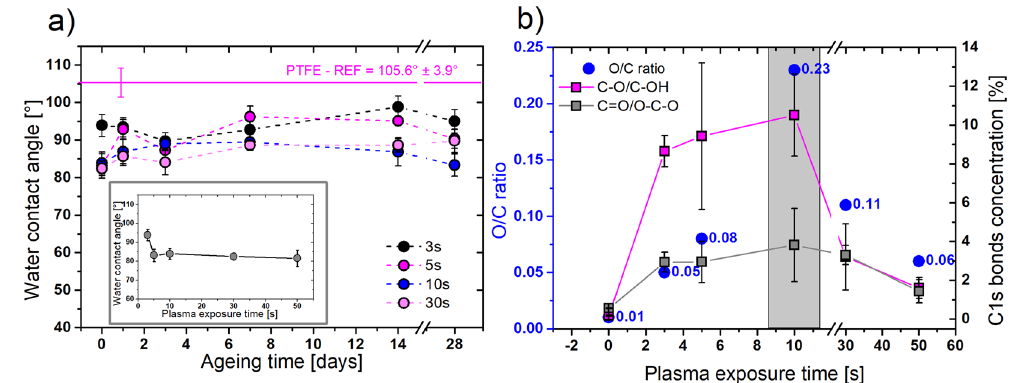
Figure 2. Optimization of PTFE plasma pre-treatment in air by WCA and XPS measurements. ( a ) Ageing behavior of air plasma-treated PTFE measured by WCA during the 28 days of storage. The inserted graph represents the WCA value development in dependence on the plasma exposure time. Mean values ± standard deviation from 12-16 droplets are plotted in the graph; ( b ) O/C ratio and concentration of O-based functional groups at the PTFE surface in dependence on the plasma exposure time, measured by XPS. Mean values ± standard deviation from 3 spots on the sample are